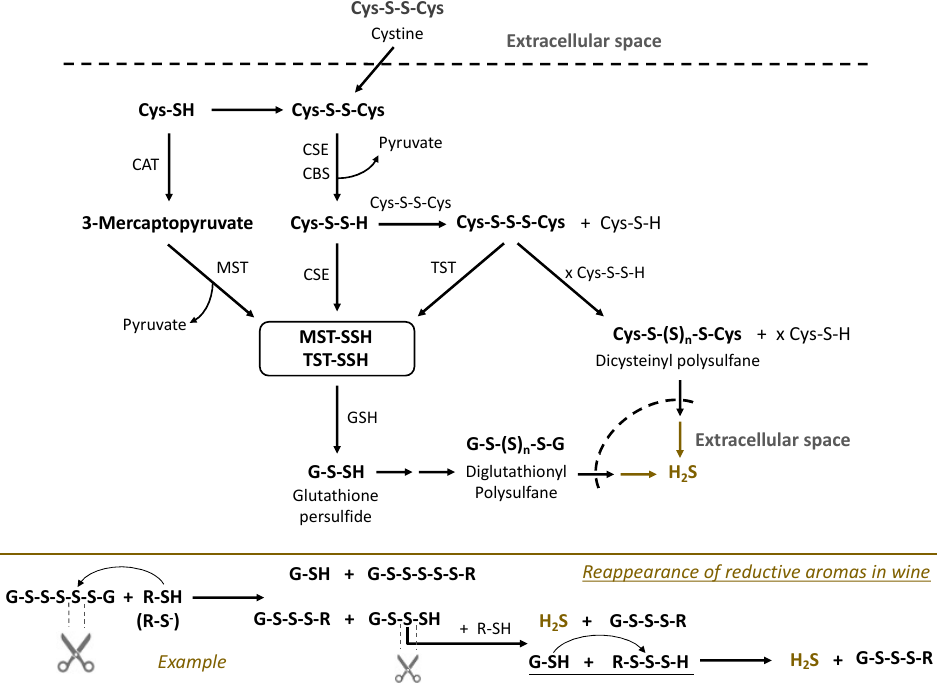
Figure 4. Formation of polysulfanes in Saccharomyces cerevisiae and the enzymes involved in sulfur metabolism (based on [24,29]). CAT — cysteine aminotransferase; CSE — cystathionine- γ -lyase; MST — 3-mercaptopyruvate sulfurtransferase; TST — thiosulfate sulfurtransferase (rhodanese); also involved is CBS: cystathionine-ß-synthase. MST-SSH and TST-SSH stand for the persulfides of the corresponding enzymes in Table 3. The lower block is an example of polysulfane reactions in wine releasing reductive aromas, e.g., H 2 S.